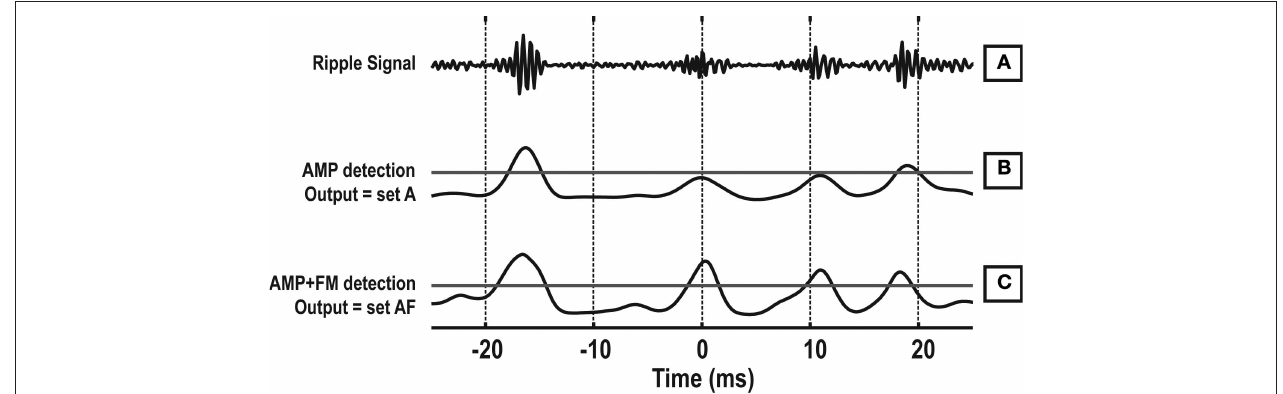
FIGURE 8 | Example of ripple detection using combined frequency and amplitude information. (A) The ripple band signal. (B) The amplitude envelope of the ripple band signal, which is normally used for ripple detection. The